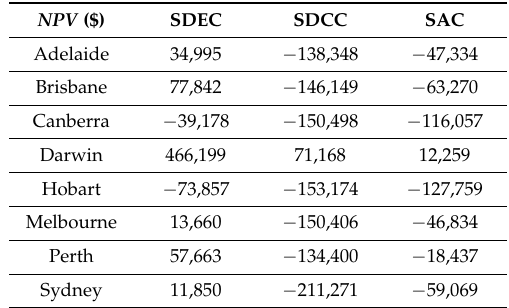
Table 15. Net present value of different solar cooling